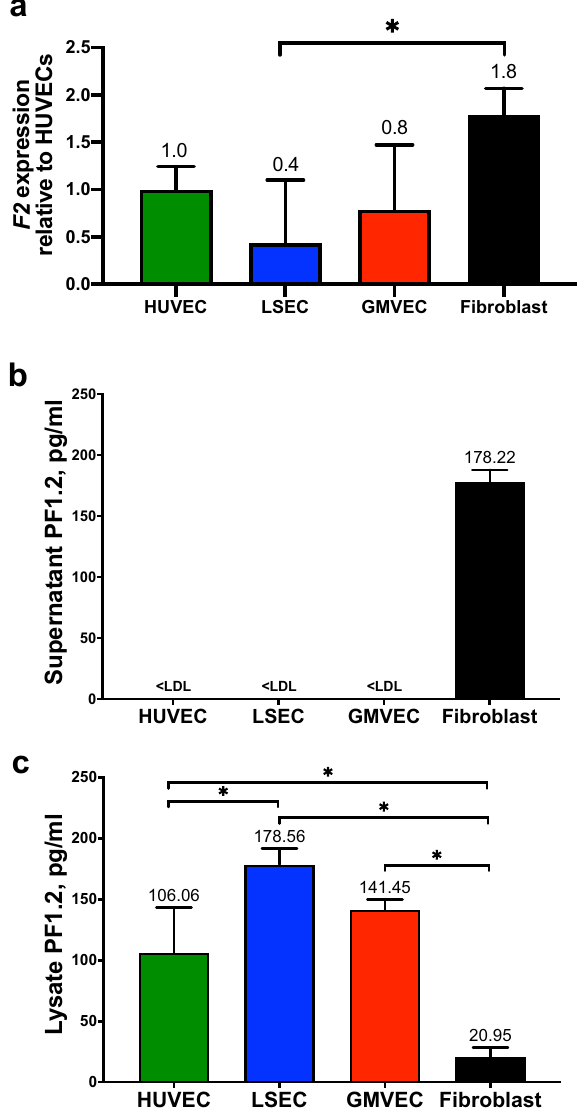
Figure 2. Gene expression of F2 and PF1.2 levels in supernatant and lysate/cell membrane fractions of ECs and fibroblasts. ( a ) The F2 expression levels in each cell type was quantified relative to F2 levels in HUVECs after normalization to GAPDH in each real-time PCR analysis. Data shown are means + SD from four to six separate RNA extractions for each cell type (HUVEC, n = 6, LSEC, n = 6, GMVEC, n = 5, fibroblast, n = 4). Levels of PF1.2 were quantified in cell ( b ) supernatant and ( c ) lysates/cell membrane fractions of HUVECs (n = 3), LSECs (n = 3–4), GMVECs (n = 3), and fibroblasts (n = 3). PF1.2 concentrations (means + SD) in pg/ml were normalized to total lysate protein to account for cell number differences. Values below the lowest detectable limit of the assay are noted as < LDL. * p <